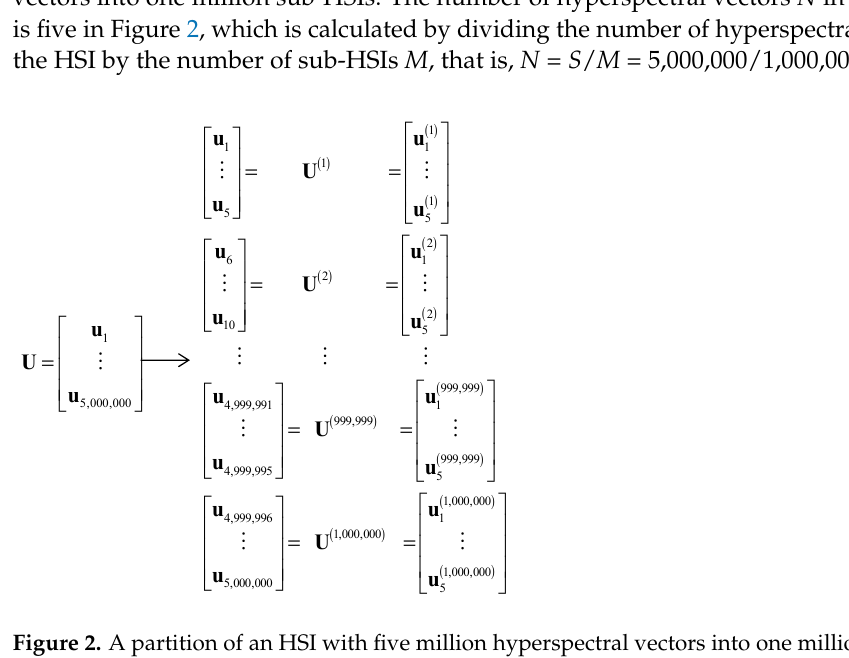
Figure 2. A partition of an HSI with five million hyperspectral vectors into one million sub-HSIs.